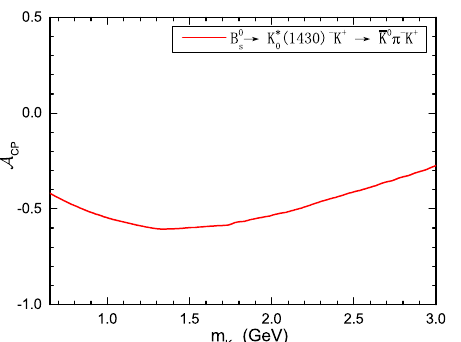
Figure 3 . Di(cid:11)erential direct CP asymmetry for the decay B 0